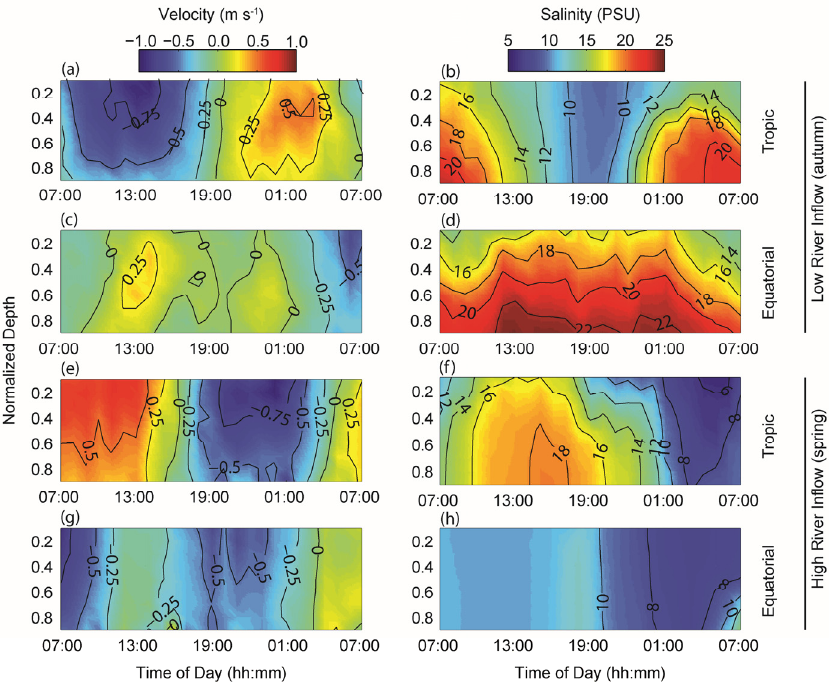
Figure 8. Intratidal variation of vertical current ( a , c , e , g ) and salinity ( b , d , f , h ) profiles collected under high and low river inflow conditions during tropic and equatorial tides. Positive velocity values indicate landward flow, negative values denote seaward flow.